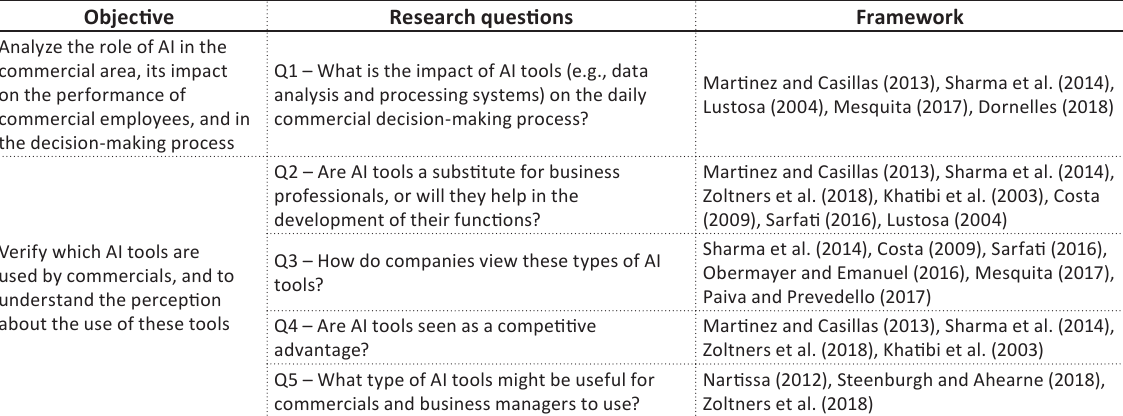
Table 1. Framework of the research objectives and research